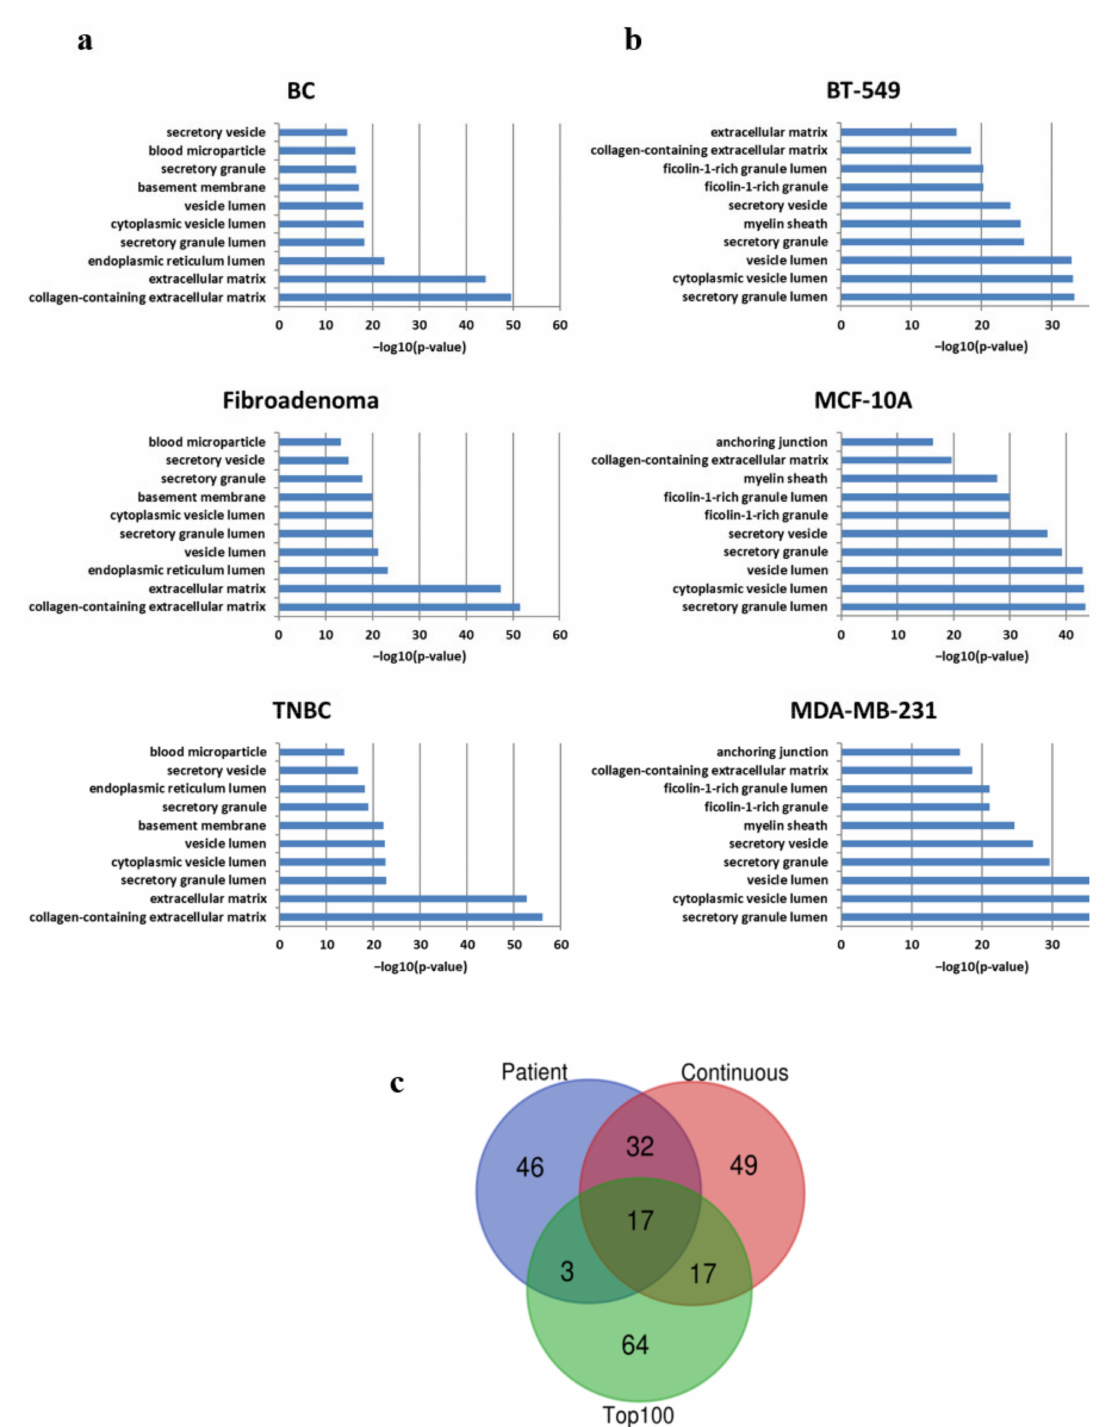
Figure 3. Proteome-wide identification of patient and model cell line EV cargoes. ( a ) Gene ontology cellular component of patient-derived EVs. ( b ) Gene ontology cellular component of continuous- derived EVs. ( c ) Venn diagrams of overlapping protein for patient and model cells including exosomal markers (ExocartaDB TOP 100